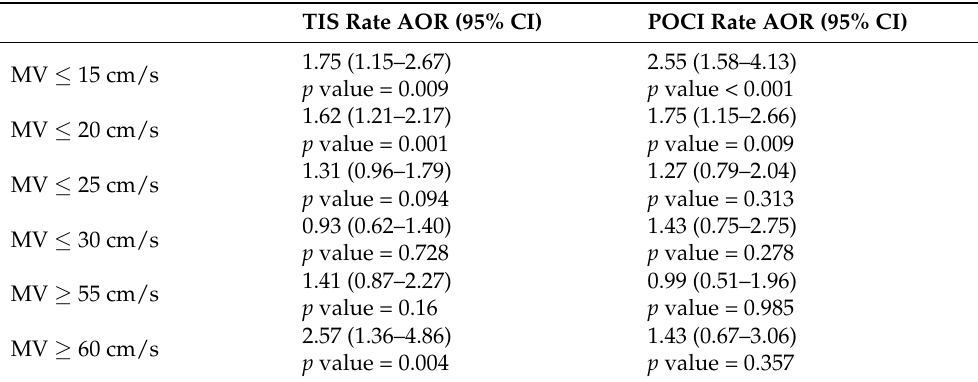
Table 3. Adjusted odds ratio and 95% confidence interval (CI) according to grouped analysis of different